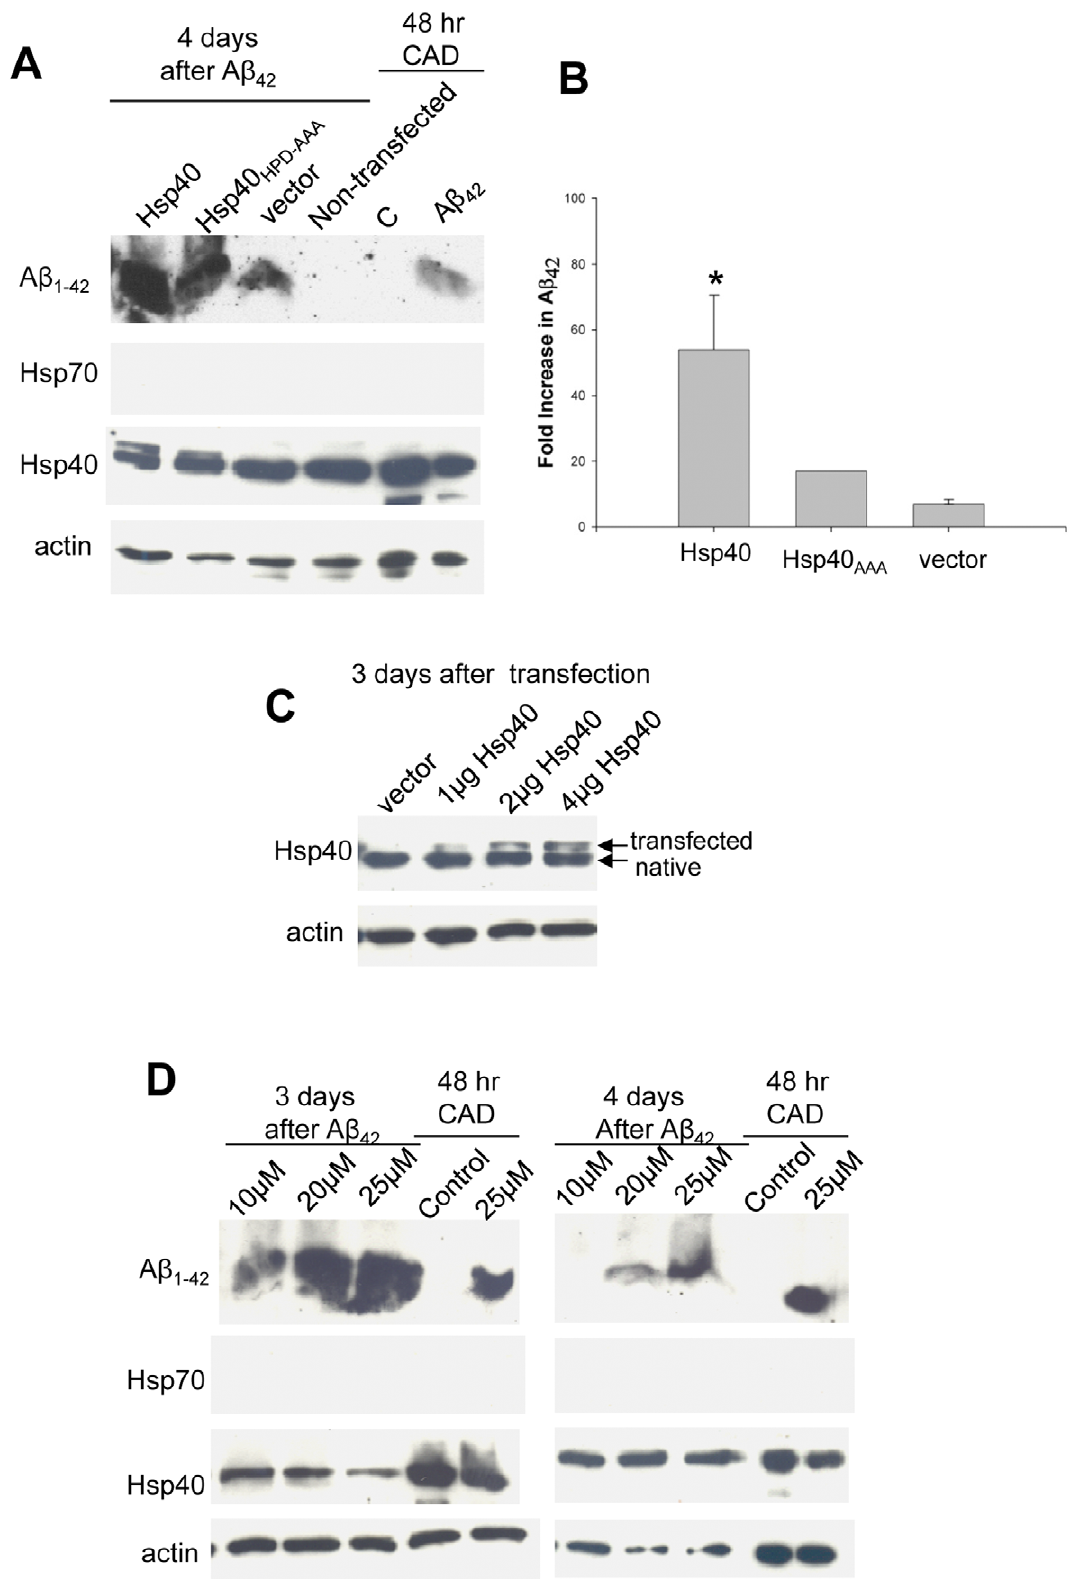
Figure 9. Transfection of hippocampal co-cultures with Hsp40 or Hsp40 HPD-AAA elevates cellular A b 42 . ( A ) Rat hippocampal neurons were transfected by electroporation with 4 m g myc-tagged Hsp40, Hsp40 HPD-AAA or vector alone. Three days after transfection, neurons were incubated with 10 m M A b 42 and 7 days post transfection hippocampal cultures were washed in PBS and cellular (total) A b 42 was determined by